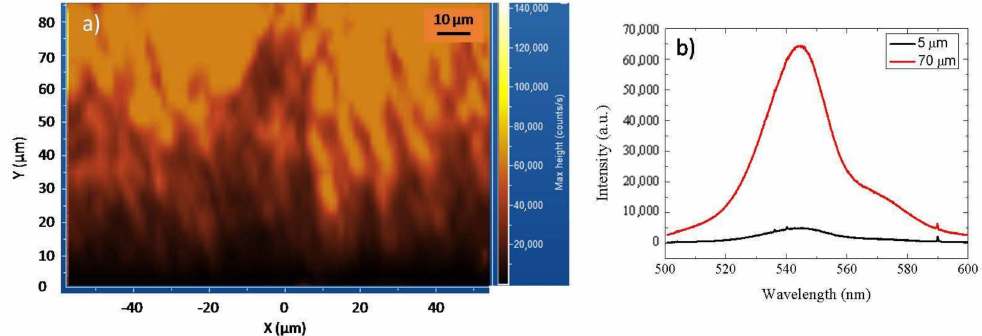
Figure 3. ( a ) Micro-photoluminescence (PL) map at 540 nm of a 3C-SiC crosssection. The point 0 on the Y axis indicates the interface removed with the silicon. ( b ) PL spectra extracted at various thicknesses. The interface removed with the silicon is placed at 0 µ